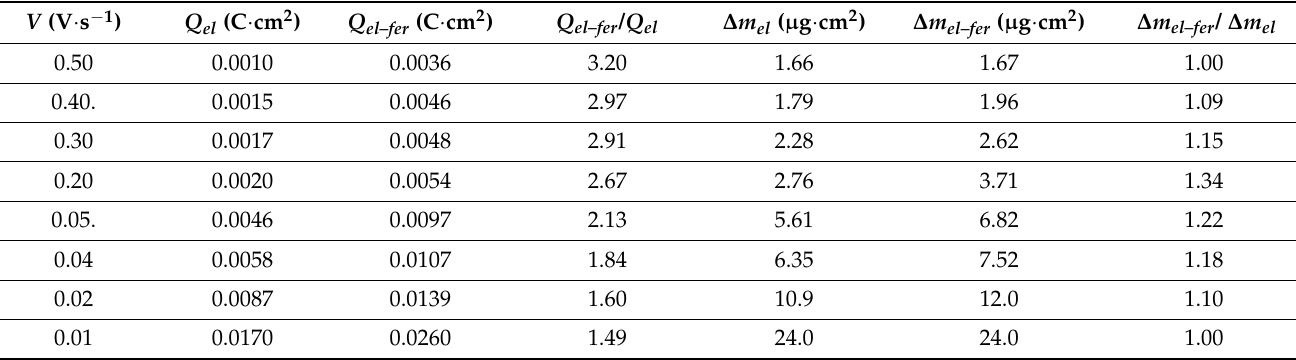
Table 1. Data from EQCM method for oxidation of poly [Ni(salcn)], obtained as a result of 3 electro-